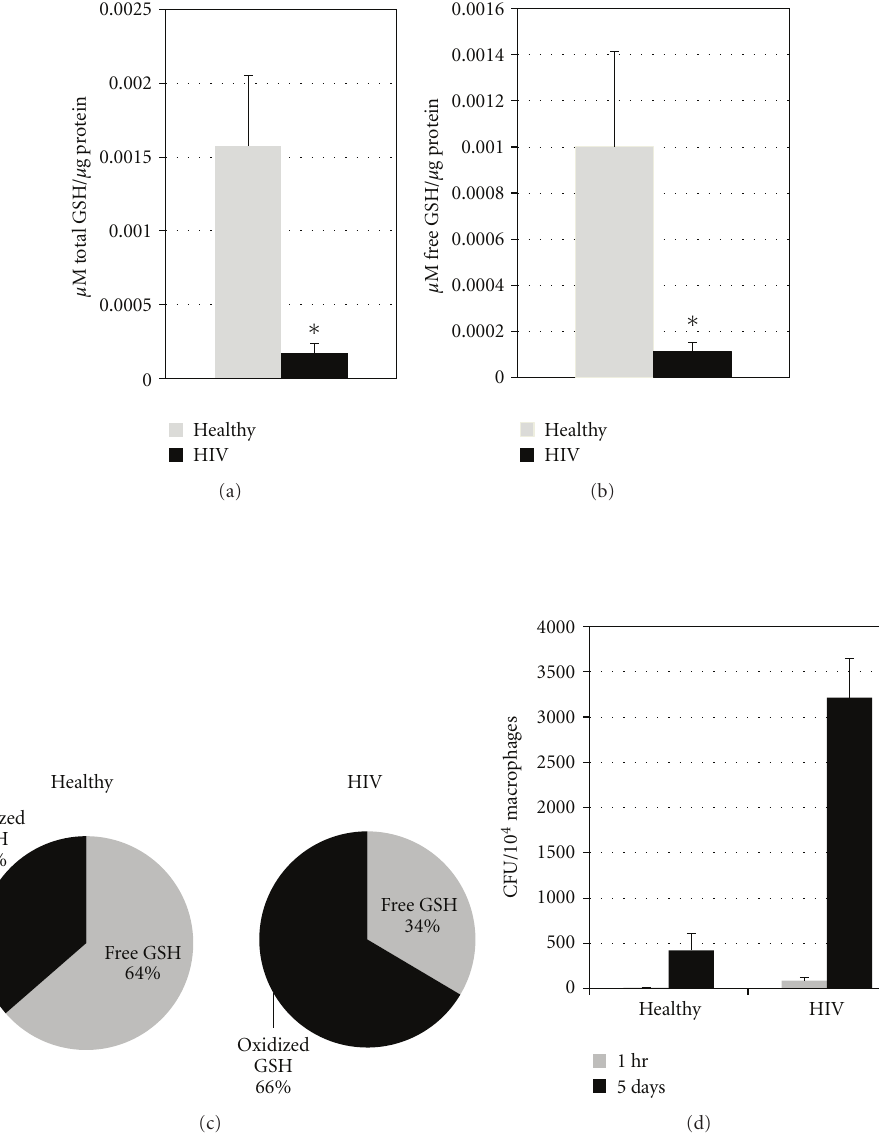
Figure 4: (a) Assay of total GSH concentrations in macrophage lysates from HIV-infected and healthy subjects. GSH levels were measured in isolated macrophages from healthy subjects and individuals with HIV infection by spectrophotometry using an assay kit from Arbor Assays. Briefly, an equal volume of ice cold 5% 5-SSA was added to the macrophage (3 × 10 5 ) pellet. Supernatants collected after centrifugation were analyzed for total, and oxidized GSH as per manufacturer’s instructions. All GSH measurements were normalized with total protein levels. Data in (a) represent means ± SE from five di ff erent healthy and HIV-infected individuals. GSH concentrations are decreased in HIV- infected macrophages with respect to healthy macrophages ( ∗ P ≤ 0 . 05). (b) Assay of free GSH concentrations in macrophage lysates from HIV- infected and healthy subjects. Free GSH was calculated by subtracting measured oxidized GSH concentrations from the measured total GSH concentrations, per the manufacturer’s instructions. Data in (b) denote means ± SE from five di ff erent healthy and HIV-infected individuals. GSH concentrations are decreased in HIV-infected macrophages with respect to healthy macrophages ( ∗ P ≤ 0 . 05). Free GSH concentrations are decreased in HIV-infected macrophages with respect to healthy macrophages ( ∗ P ≤ 0 . 05). (c) A comparison of the composition of the total GSH in healthy and HIV-infected subjects reveals that the majority of GSH in HIV-infected macrophages exists as oxidized GSH ( ∼ 70%), whereas healthy macrophages contain a more balanced GSH makeup ( ∼ 40% oxidized, ∼ 60% free). (d) Intracellular growth of M. tb in macrophages from healthy and HIV-infected individuals at 1 hour, and 5 days postinfection . Human monocyte-derived macrophages (from healthy and HIV-infected individuals) were infected with the processed H37Rv at a multiplicity of infection of 10:1. Infected macrophages were terminated at 1 hour and 5 days postinfection to determine the intracellular survival of H37Rv inside macrophages from healthy and HIV-infected individuals. Macrophage lysates were plated on 7H11 medium enriched with ADC to estimate the growth or killing of H37Rv. Results shown in (d) are averages from n = 4 HIV and n = 5 healthy. Each experiment was performed in triplicate. Macrophages from HIV-infected subjects demonstrate a markedly decreased ability to control intracellular M. tb